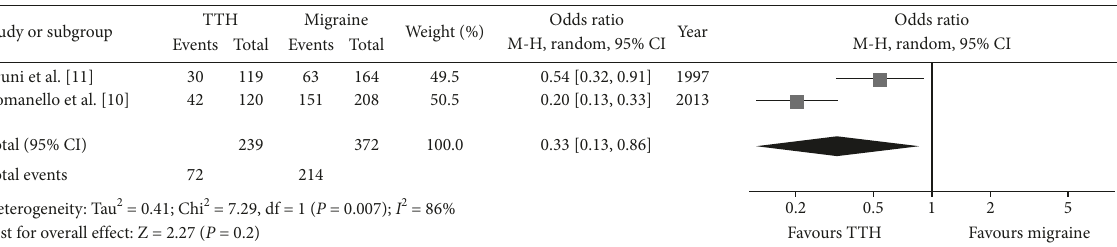
Figure 4: Forest plot of the incidence of infant colic between migraineurs and TTHs. TTH, tension-type